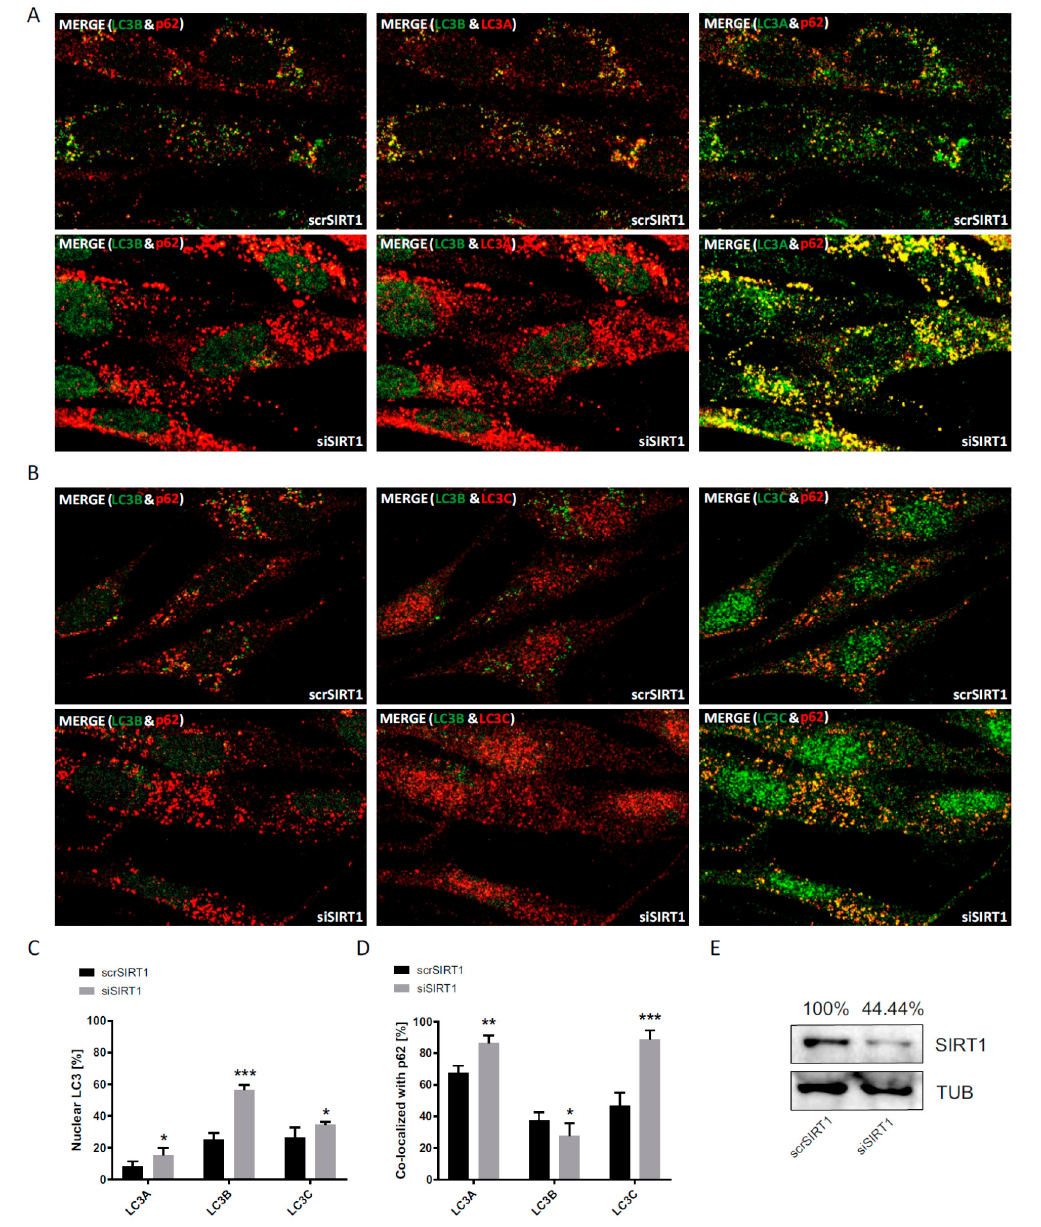
Figure 5. Analysis of the cellular localization of LC3A, LC3B and LC3C in response to siRNA-mediated Sirtuin1 knock-down. ( A ) Cellular localization of LC3A, LC3B and p62 after transfection with Sirtuin1 siRNA (siSIRT1-RNA) or scrambled RNA (scrSIRT1-RNA) under BafA1 treatment. ( B ) Cellular localization of LC3C, LC3B and p62 after transfection with Sirtuin1 siRNA (siSIRT1-RNA) or scrambled RNA (scrSIRT1-RNA) under BafA1 treatment. ( C ) Quantification of the relative nuclear fraction of LC3A, LC3B and LC3C in cells transfected as indicated. ( D ) Relative co-localization of LC3A, LC3B and LC3C with p62 quantified by image analysis. Significant changes (by two-way ANOVA) versus scrSIRT1-treated cells: * p ≤ 0.05; ** p ≤ 0.01; *** p ≤ 0.001. Data in ( C ) and ( D ) were derived from three photographed, independent experiments ( n = 3), in which 12–45 cells per image were analyzed. ( E ) Sirtuin1 protein expression after transfection with scrSIRT1-RNA or siSIRT1-RNA. Tubulin was used as loading control.